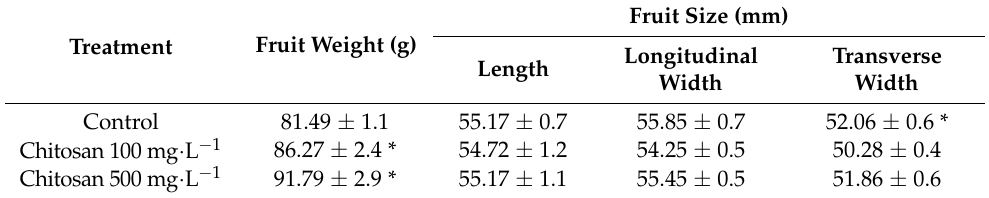
Table 1. Effects of preharvest chitosan application on fruit weight and fruit size at harvest in ‘Garmrok’ kiwifruit. Experimental data represent means ± standard error with n = 10. * in each column indicate significant differences between treatments on harvest day, according to the least significant difference (LSD) test at p ≤